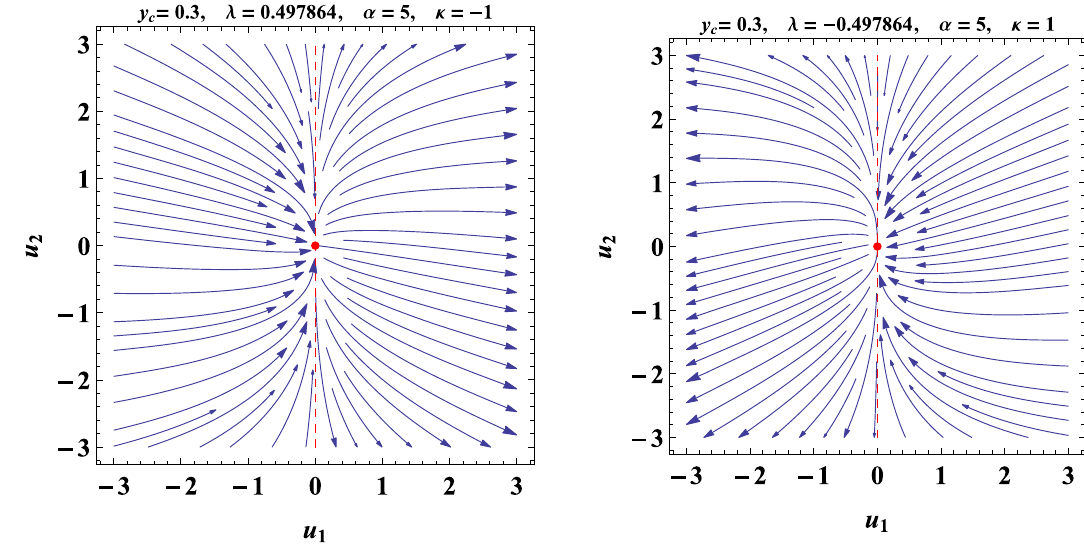
Fig. 5 Phase plot of system (58) for some values of the parameters showing that A (cid:4)